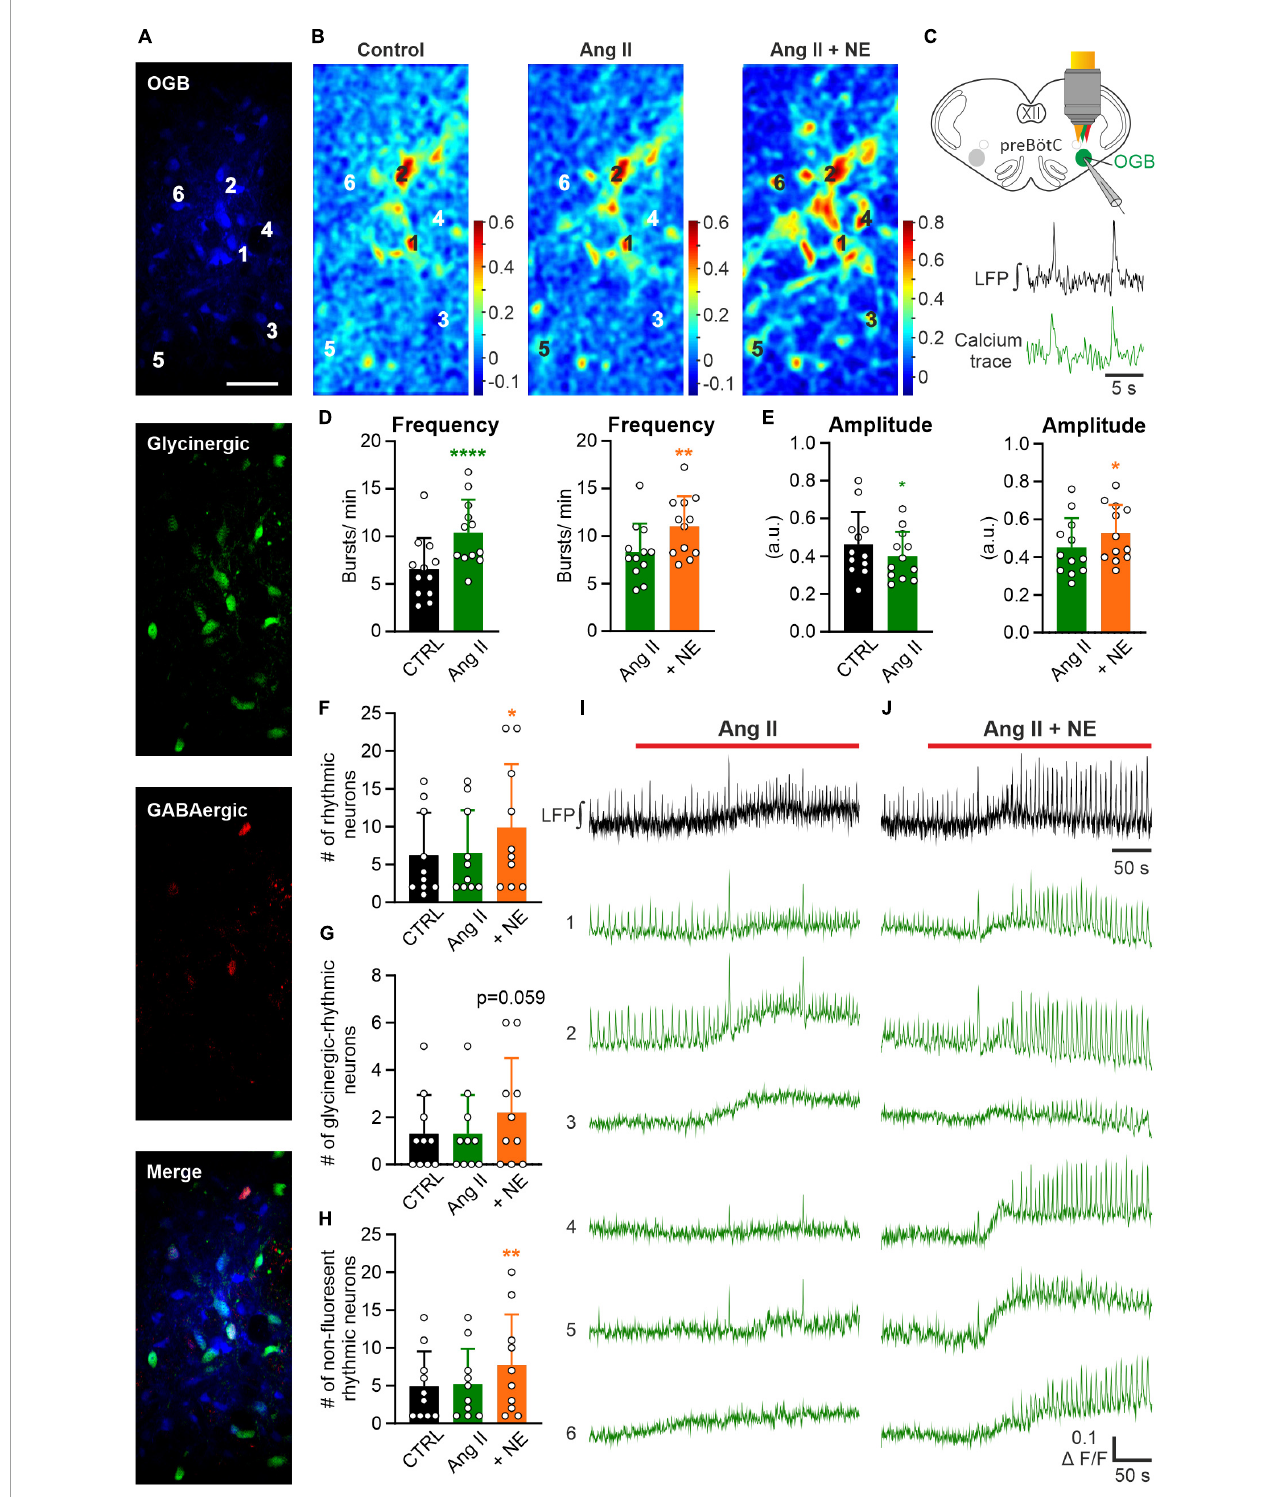
FIGURE5 Effect of Ang II is not mediated by recruitment of additional rhythmic neurons. LFP recordings were combined with 2P microscopy in acute rhythmic slices. Oregon Green 488 BAPTA-1AM (OGB) was pressure injected into the preBötC. (A) Images of neurons loaded with OGB from COFLOUR mice expressing EGFP in glycinergic and tdTomato in GABAergic interneurons. Scale bar 50 µ m. (B) Cross-correlation maps of the LFP and calcium responses for the different treatment groups. Norepinephrine (NE; 10 µ M) was added to Ang II. (C) Schematic drawing of an OGB injected slice, showing LFP and calcium traces of a rhythmic neuron below. (D,E) The baseline of the LFP was recorded for 5 min before the treatment was applied. Charts show averaged LFP data from imaging experiments (control condition was recorded for 3 min–time interval 2–5 min and the treatment groups for 4 min–time interval 8–12 min), N = 12 slices. (F) Chart shows the mean number of all rhythmic neurons, which is then divided into (G) glycinergic-rhythmic and (H) non-fluorescent rhythmic neurons. N = 10 slices. The data are presented as mean ± SD and were tested using a (D,E) paired Student’s t -test or a (F–H) RM one-way ANOVA. * p < 0.05; ** p < 0.01; **** p < 0.0001. (I,J) LFP (black) and calcium traces (green) from selected neurons (A) treated with Ang II and Ang II +